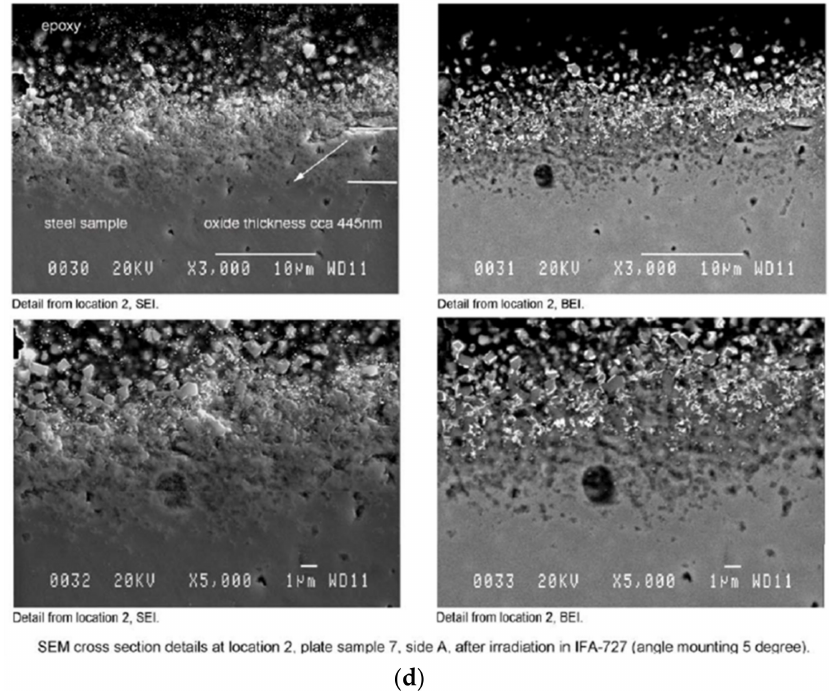
Figure 10. ( a ) Backscattered and secondary electron images from location 2 of 316L SS plate specimen 3, side A with a 22-day exposure time. ( b ) Backscattered and secondary electron images from location 2 of 316L SS plate specimen 1, side A with a 36-day exposure time. ( c ) Backscattered and secondary electron images from location 2 of 316L SS plate specimen 5, side A with a 49-day exposure time. ( d ) Backscattered and secondary electron images from location 2 of 316L SS plate specimen 7, side A with a 107-day exposure time.